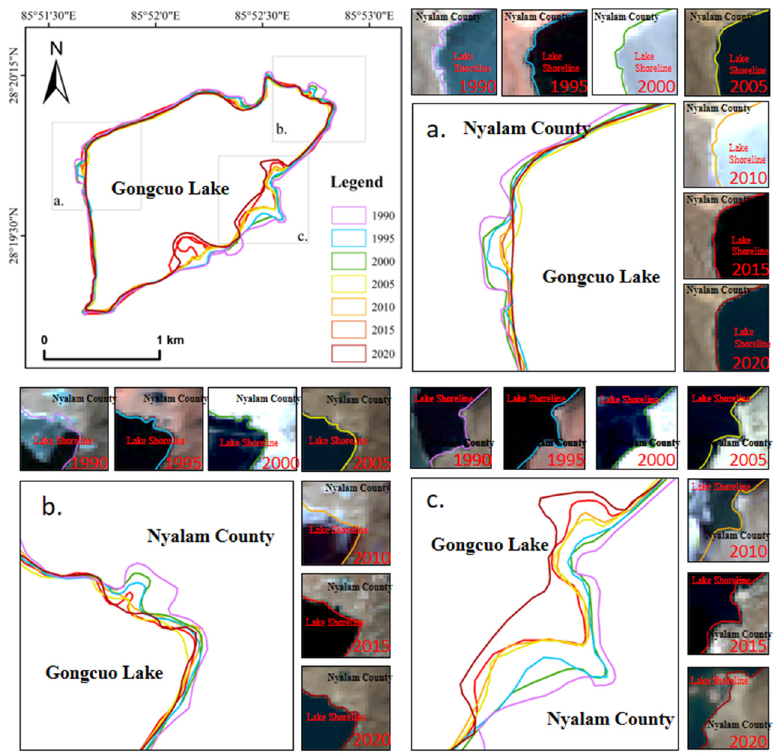
Figure 6. Thirty-year area change of glacial lake in Nyalam County (( a – c ) GongCuo Lake).